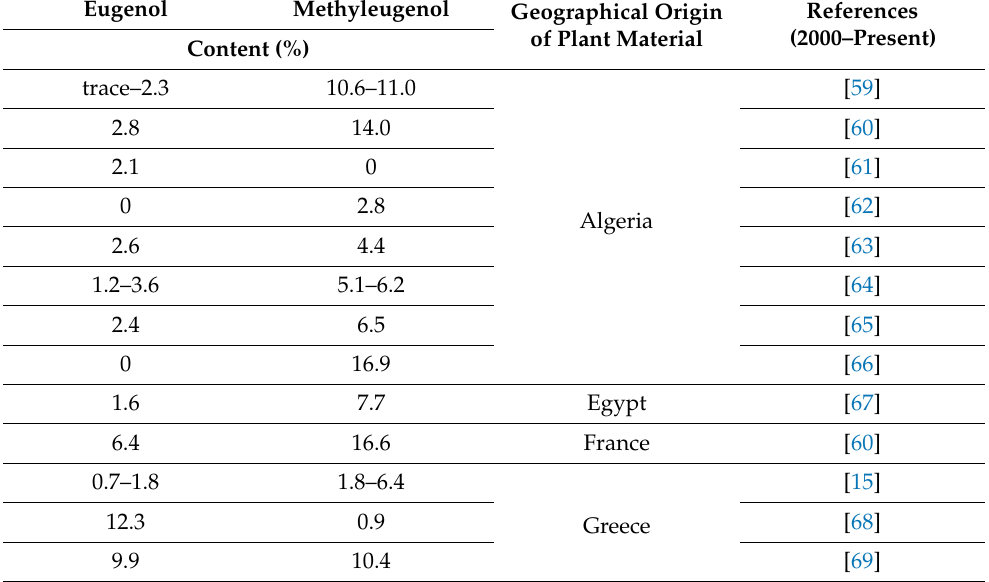
Eugenol and methyleugenol percent in bay laurel leaf EOs from different Mediterranean